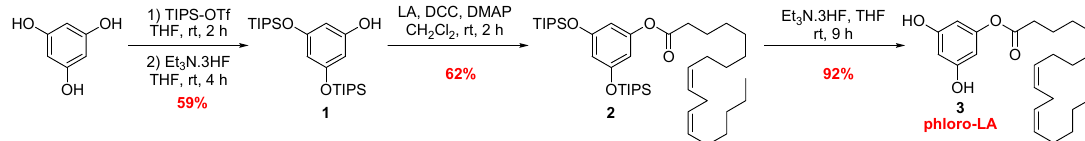
Figure 1. Synthetic pathway to access phloroglucinol-LA.